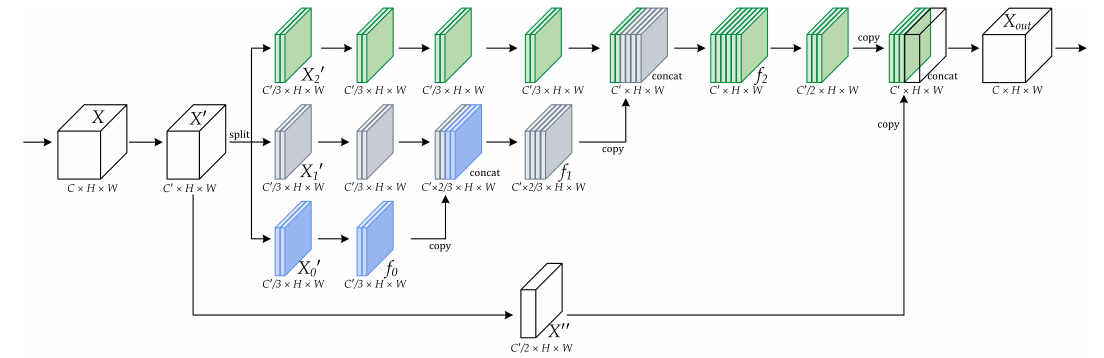
Figure 1. A Split-and-Combine